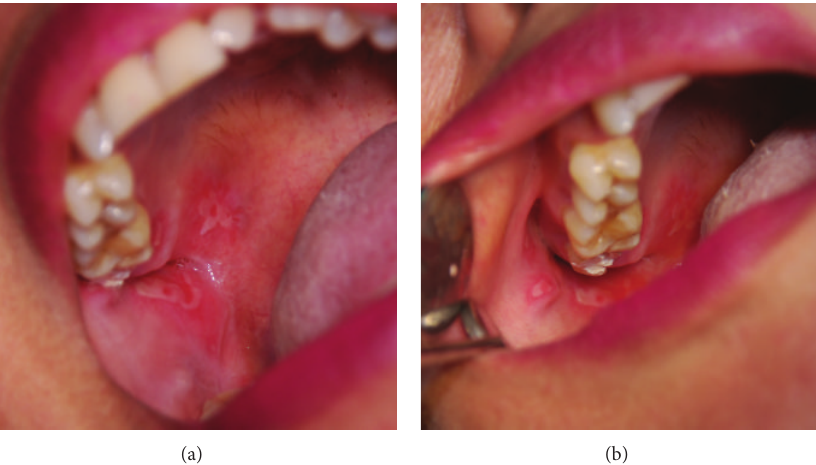
Figure 1: Shallow multiple irregular ulcers ranging from 0.3 to 1.5cm in diameter with erythematous border, located on the right buccal mucosa, palatal mucosa, and gingival mucosa surrounding tooth 17.